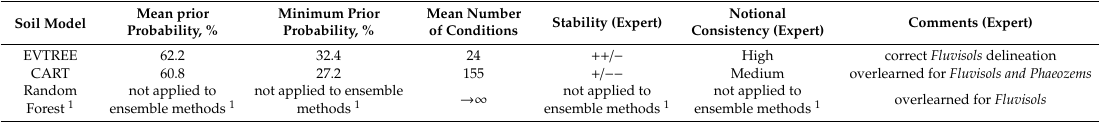
Table 4. Quality assessment parameters of the